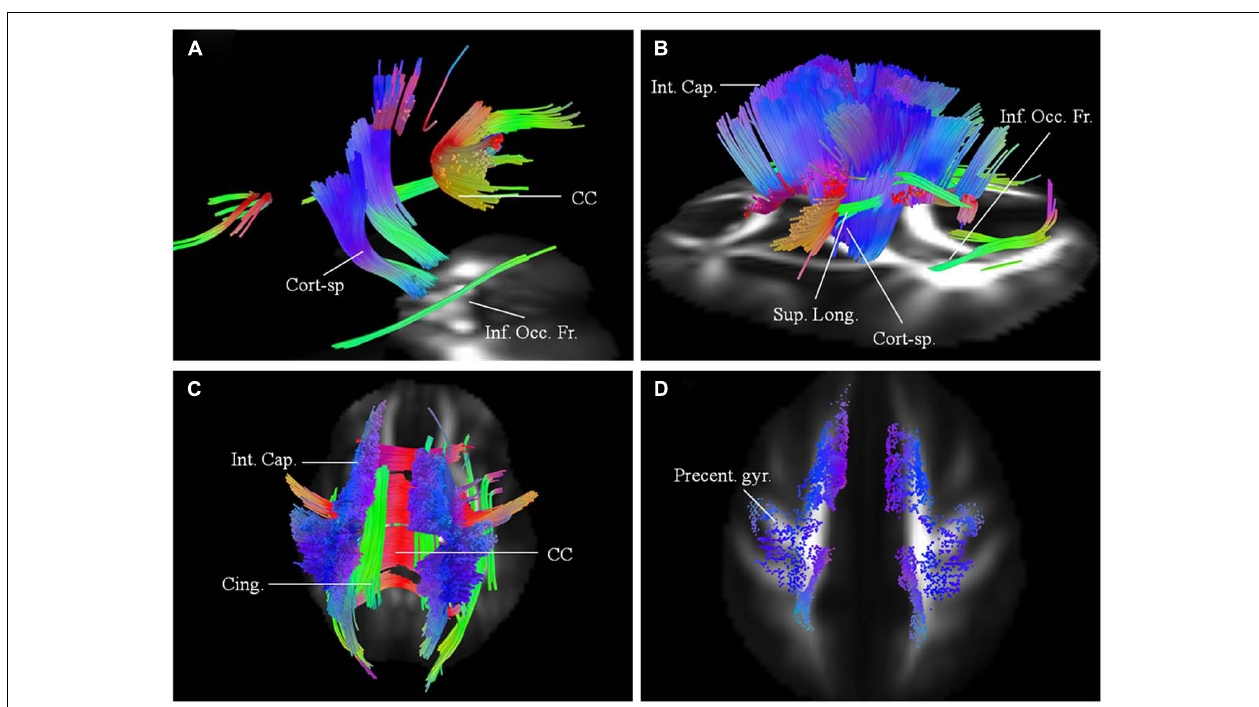
FIGURE 3 | (A) Baseline diffusion connectometry analysis for patient 2, demonstrated the affected areas as being parts of the corpus callosum (CC), corticospinal (Cort-sp.) tracts, and inferior occipito-frontal (Inf. Occ. Fr.) fasciculi bilaterally. (B , left lateral view) and (C , posterior view) 6 months later shows extensive bilateral changes now involving corticospinal tracts, frontal